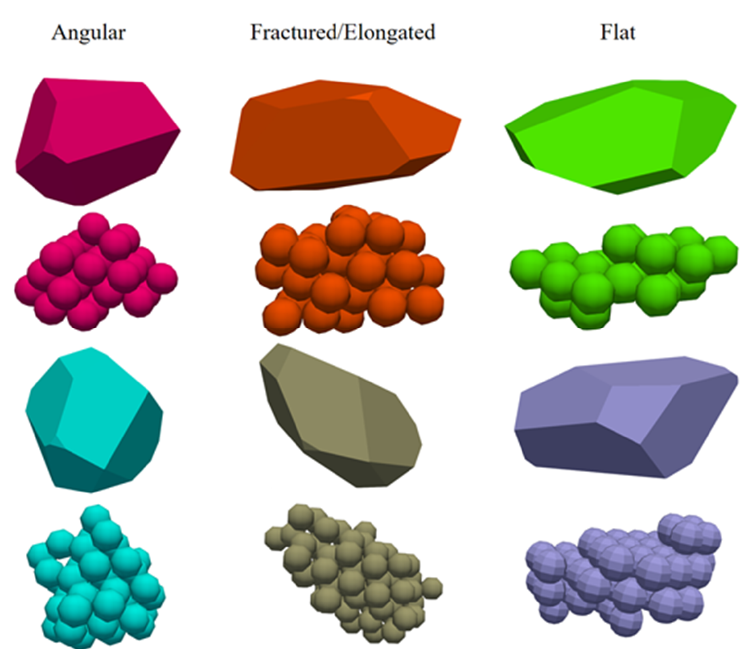
Processes 2022 , 10 , 47